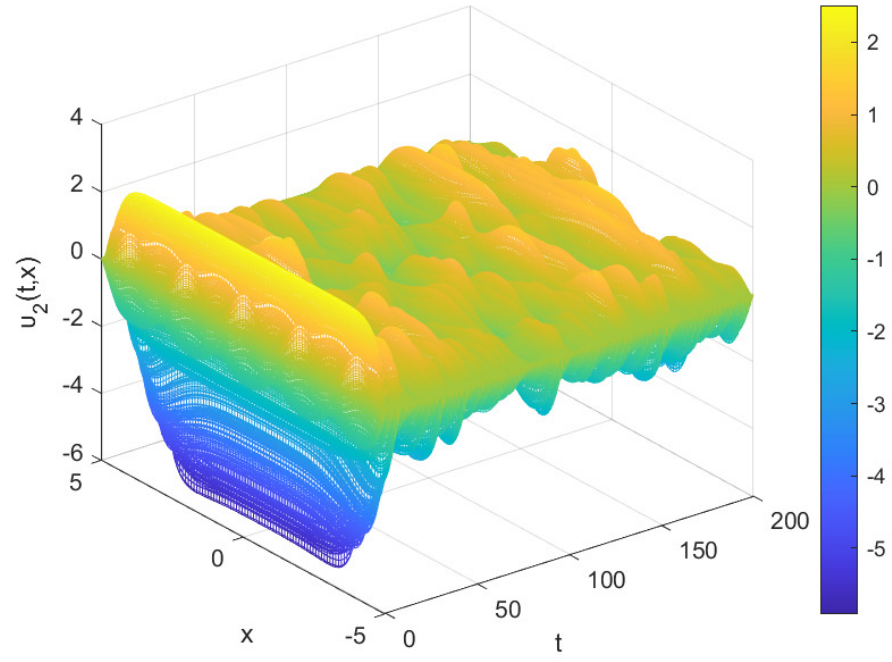
Figure 2. Time valuation of υ 2 ( t , x ) in system (31).